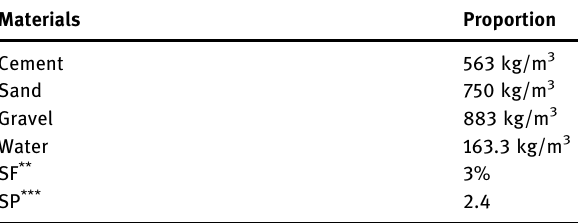
Table 9: Details of concrete proportion*